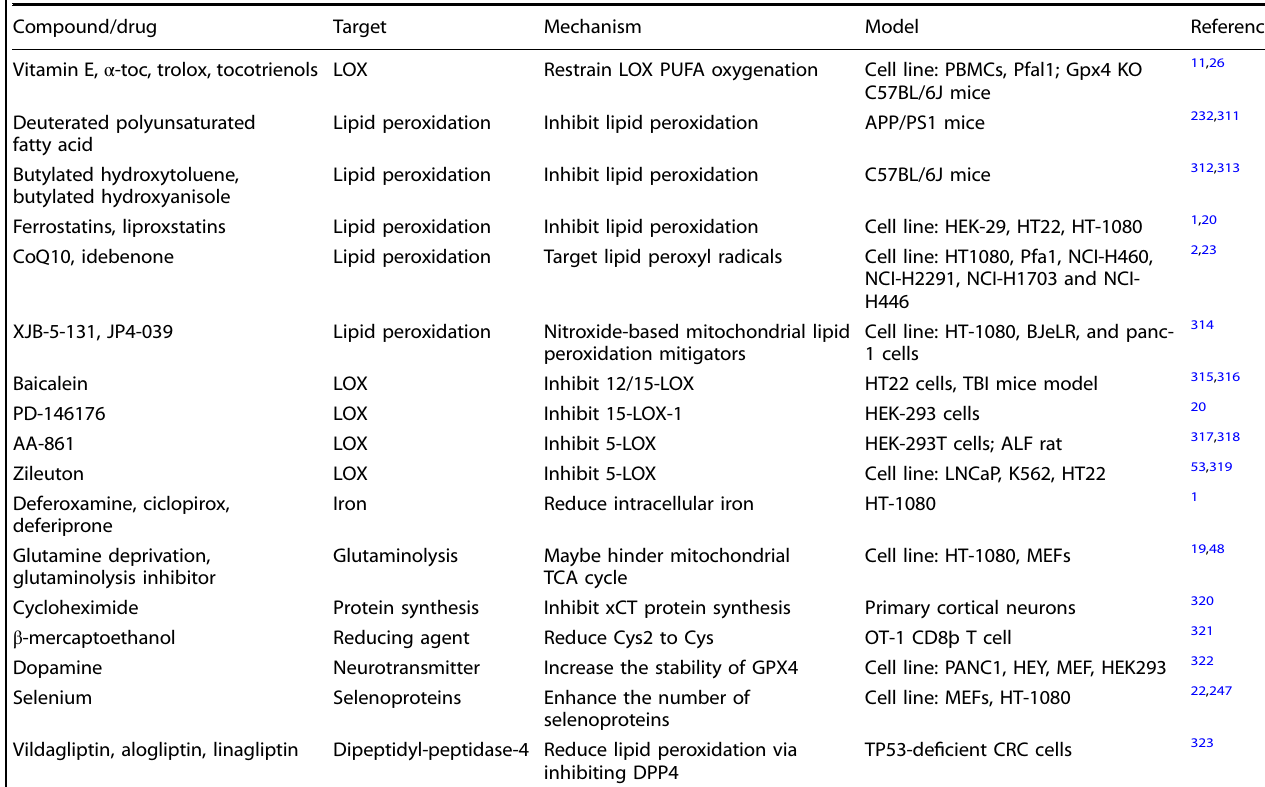
Table 2. Summary of ferroptosis inhibitors.